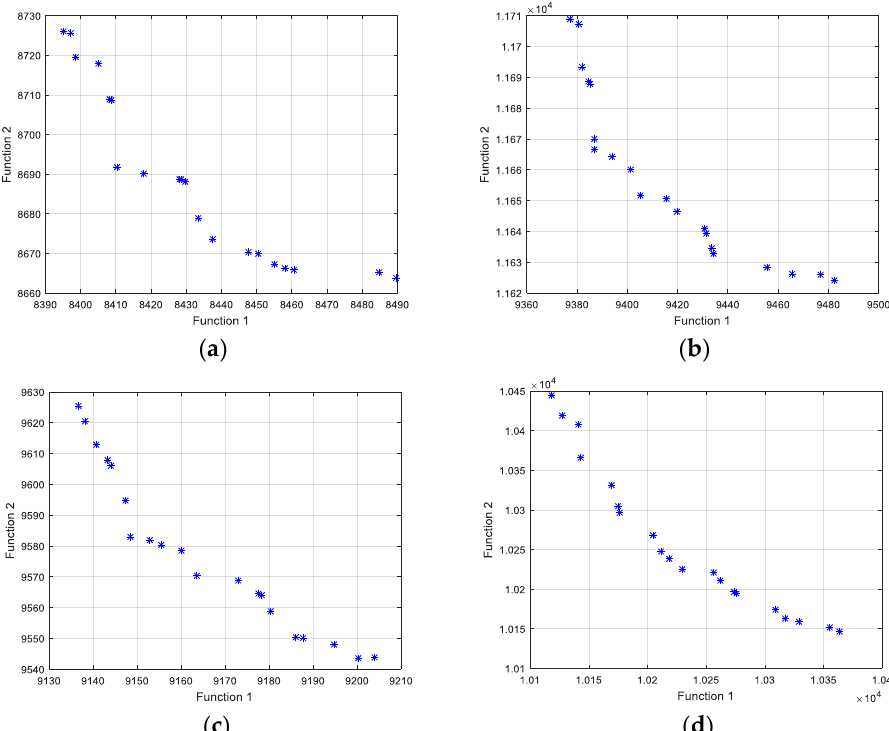
Figure 8. Two objective function relationships in four different network topologies. ( a ) The random topology; ( b ) The C-shaped random topology; ( c ) The O-shaped random topology; ( d ) The X-shaped random topology.